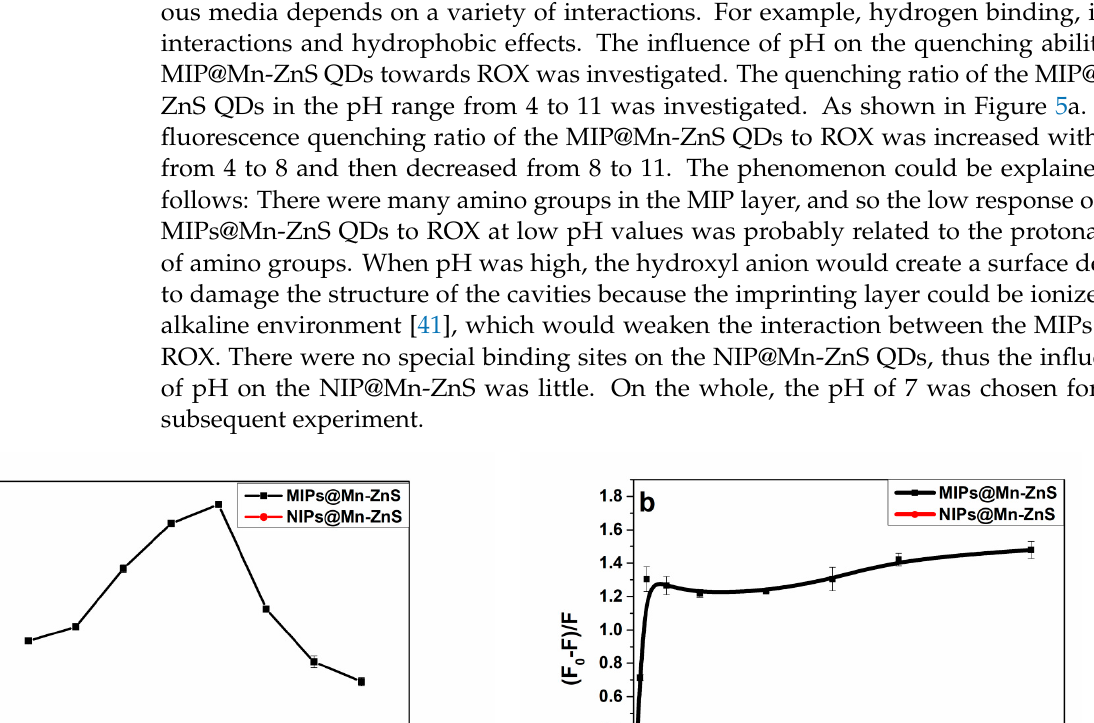
(Figure 4C(b)), MIPs@Mn-ZnS QDs (Figure 4C(c)), showed that the APTES and MIP layers were successfully modified onto the surface of the MPTS@Mn-ZnS QDs.